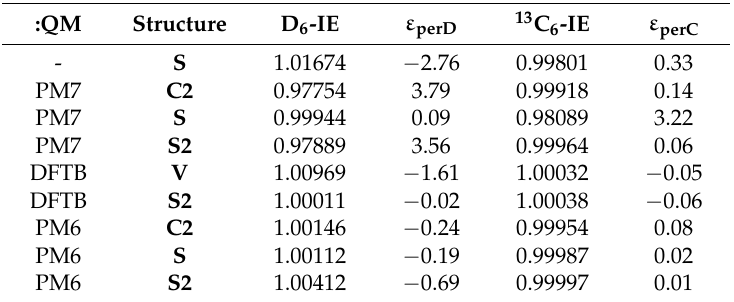
Table 3. The isotope effects (IE) and isotopic fractionations ( ε ) obtained using ONIOM QM:QM two-layer model and ω B97xd/def2-TZVPP for benzene.